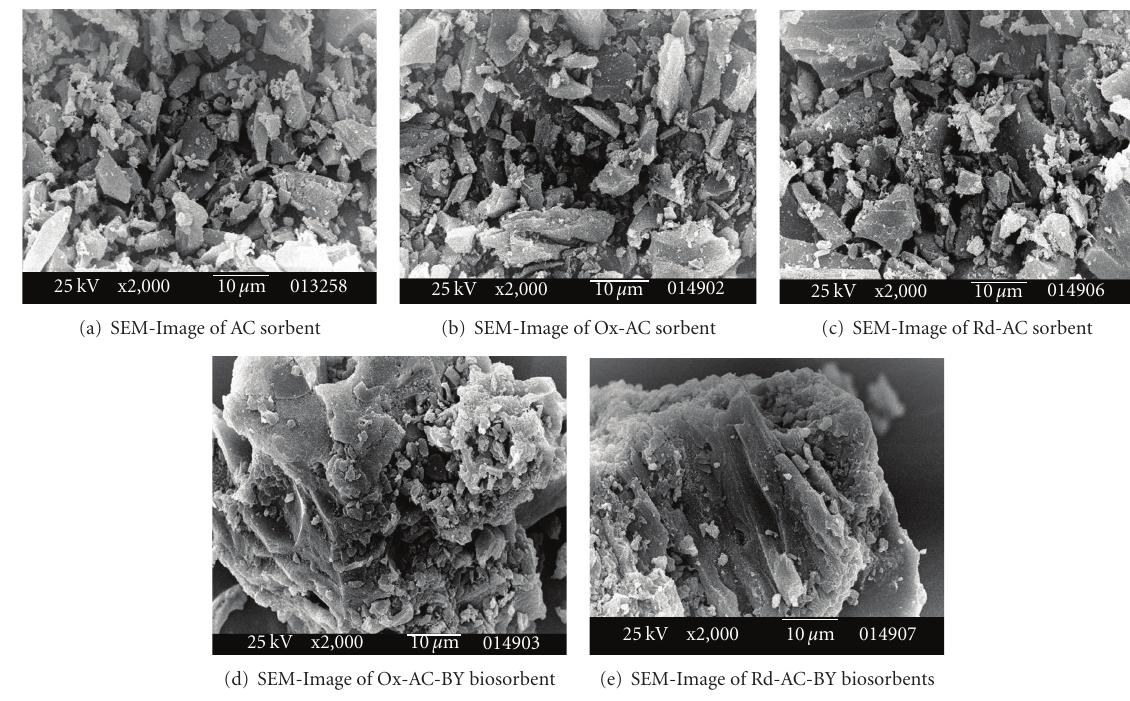
Figure 2: SEM-images of various hybrid chemically and biologically treated sorbents and biosorbents.